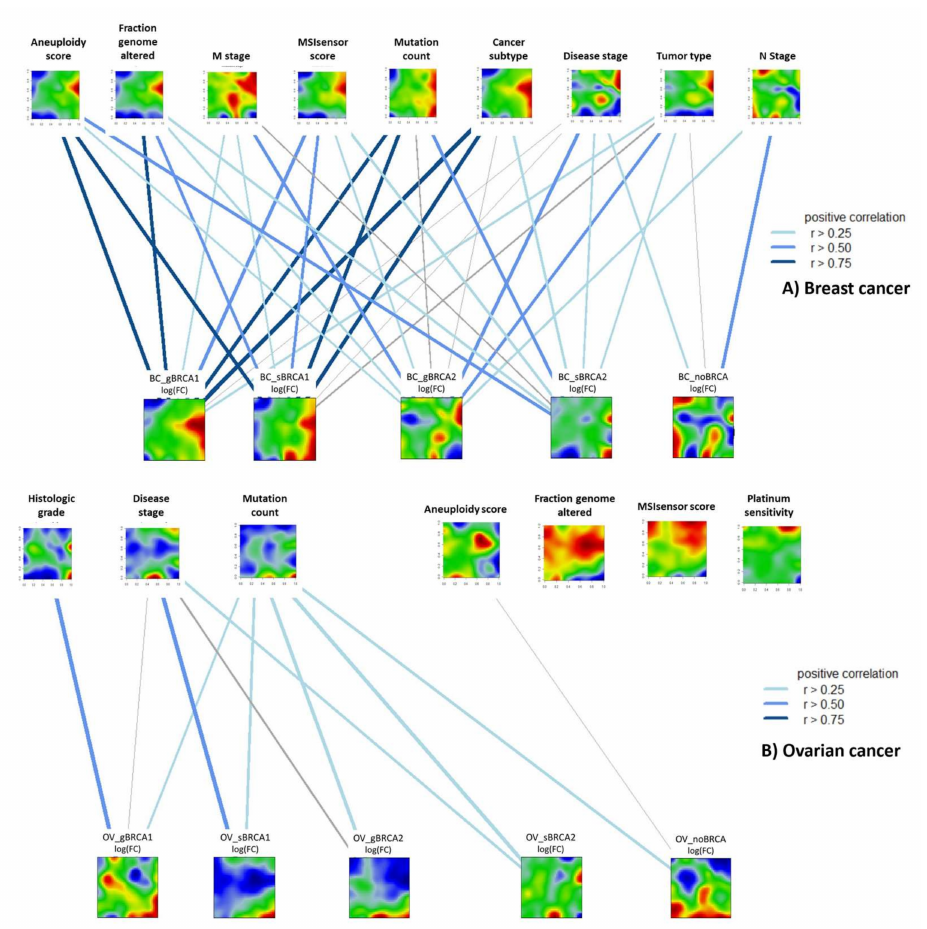
Figure 7. Phenotype-transcriptome associations in the breast ( A ) and ovarian ( B ) cancers. Phenotype maps were generated based on linear regression coefficients between corresponding characteristics and metagene expression profiles across all samples in a given dataset (See Materials and methods section). The similarity between phenotype and transcriptome was calculated for each studied group separately using Pearson’s correlation